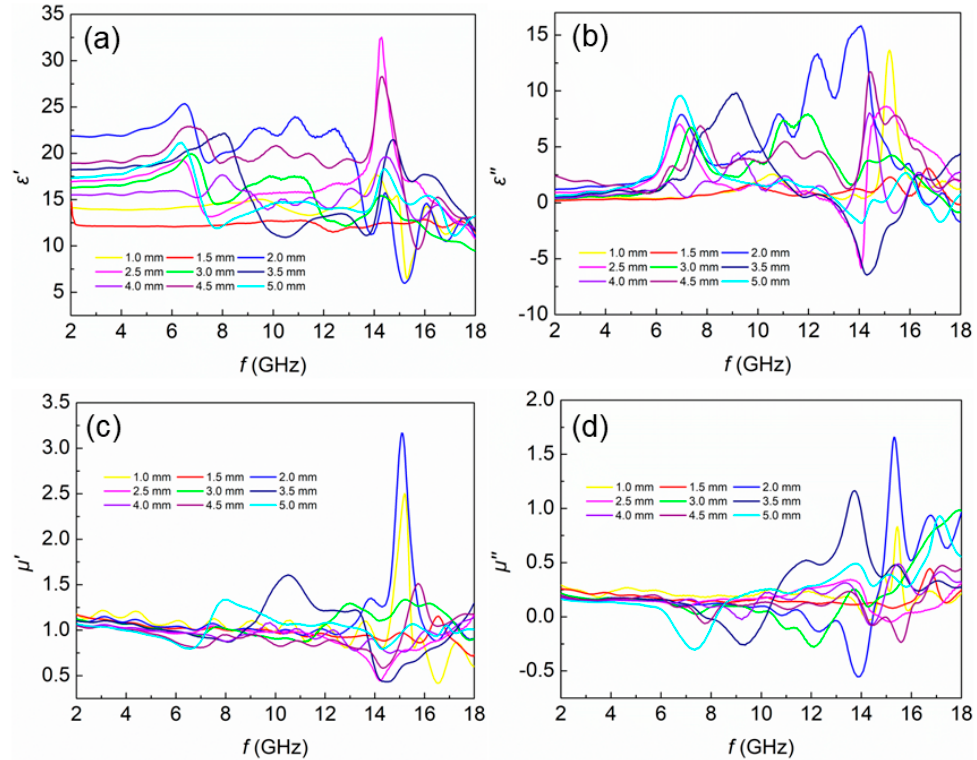
Figure 3. Frequency dependence of electromagnetic parameters of as-prepared FeSiBNi2 metallic microwires with a mass ratio of 40 wt.% with different thicknesses of composite ranging from 2–18 GHz: ( a ) ε ′ ; ( b ) ε ′′ ; ( c ) μ ′ ; ( d ) μ ′′ .